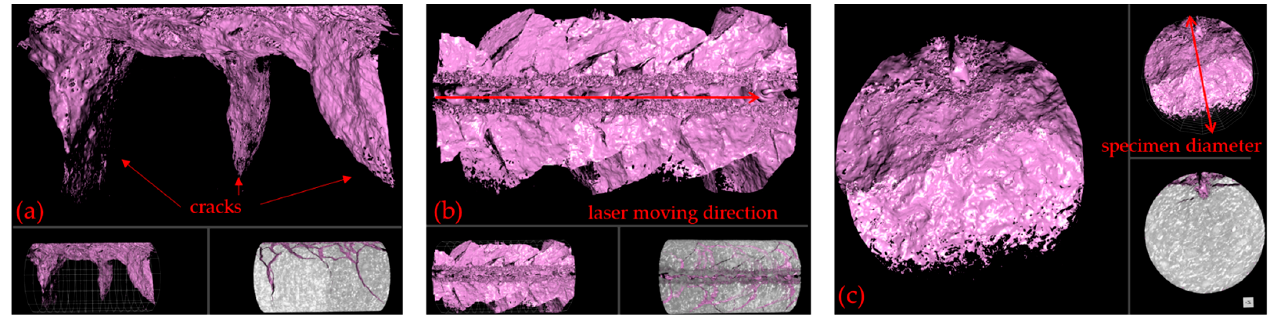
Figure 11. Rendered images of irradiated specimens from ( a ) front, ( b ) top and ( c ) right